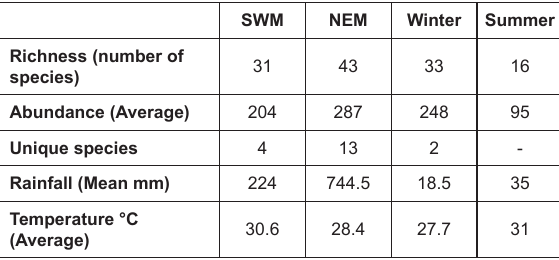
Table 2. Seasonality of butterflies in different seasons in